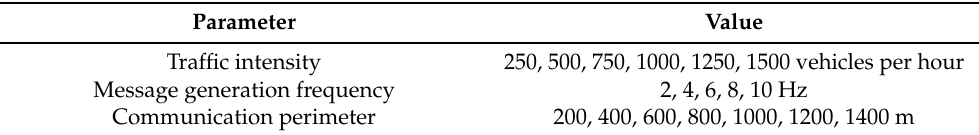
Table 1. Simulation variables.